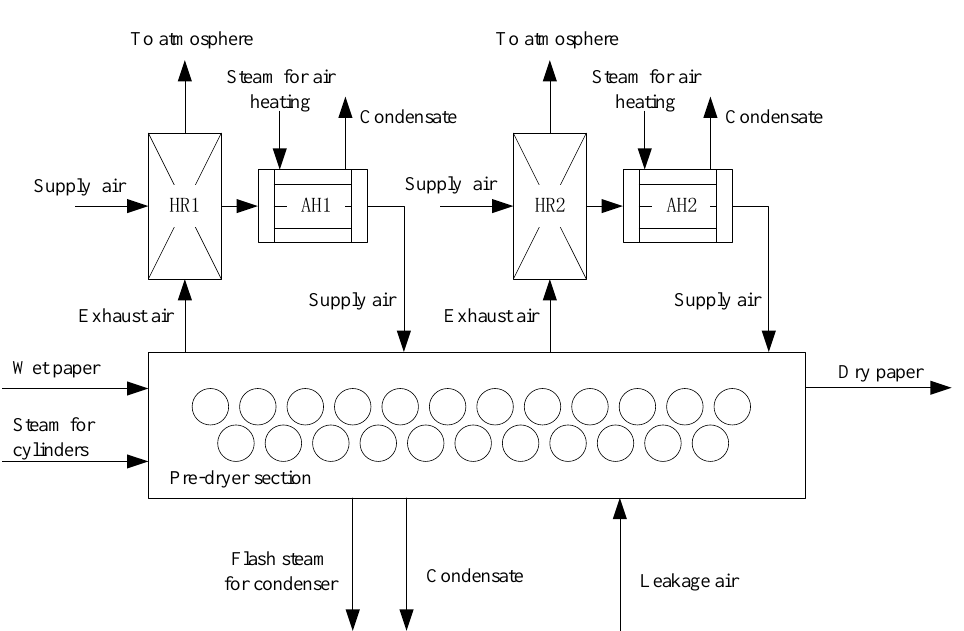
Figure 5. Schematic diagram of paper drying process.